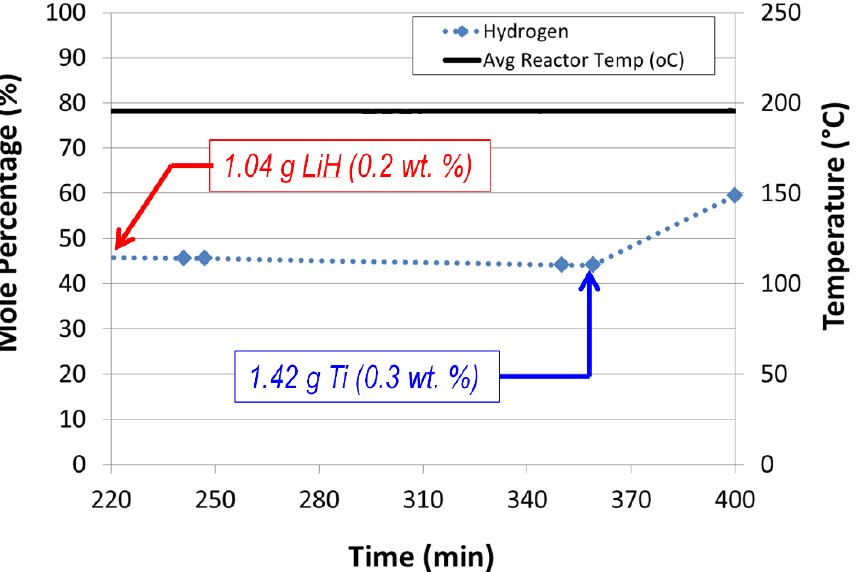
Figure 13. Effects of sequential addition of LiH and Ti t-butoxide on alane dehydrogenation in our auger reactor (60 wt% ATK alane slurry in mechanical pump fluid, auger speed = 12 rpm, feed flow rate = 1.02 mL/min).